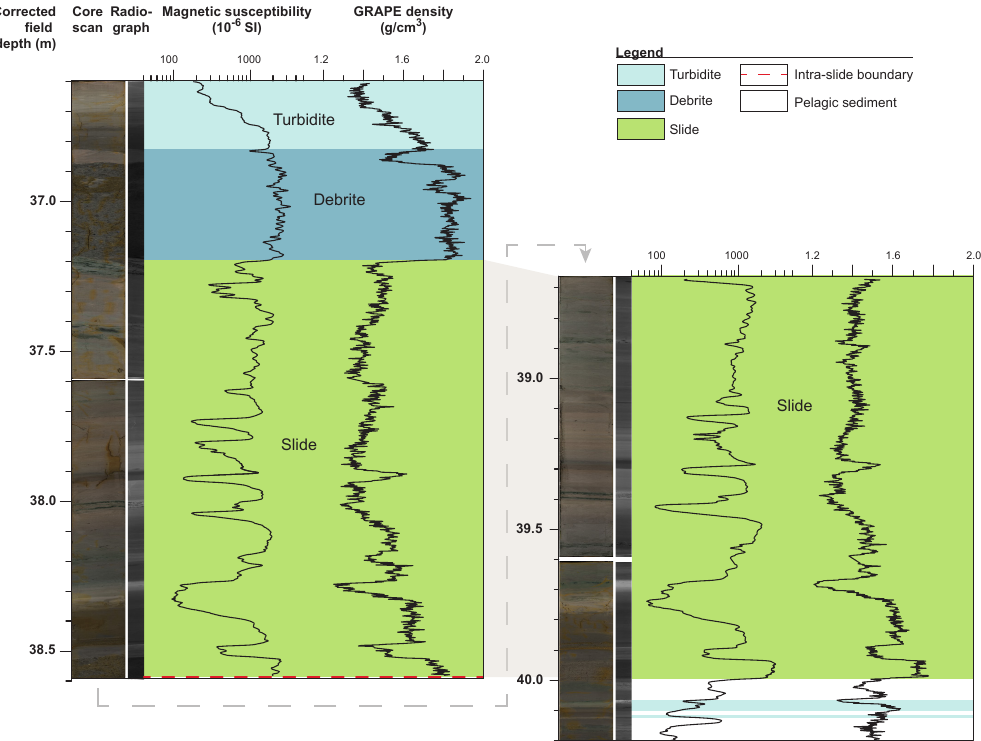
Fig. 7. Slide Si75 (age 930ka) and overlying debrite D74 in core scans 5011-1A-11H-2 to 1A-12H-2. Slide Si75 consists of a ca. 140cm thick duplicated section above and below the intra-slide boundary. The section is divided into a basal co-generic debrite-turbidite (39.7– 40.0mcfd; thickness 33cm) overlain by a 1m segment of facies B sediments (38.65–39.7mcfd). Both magnetic susceptibility and density of facies B sediments correlate nearly perfectly above and below the intra-slide